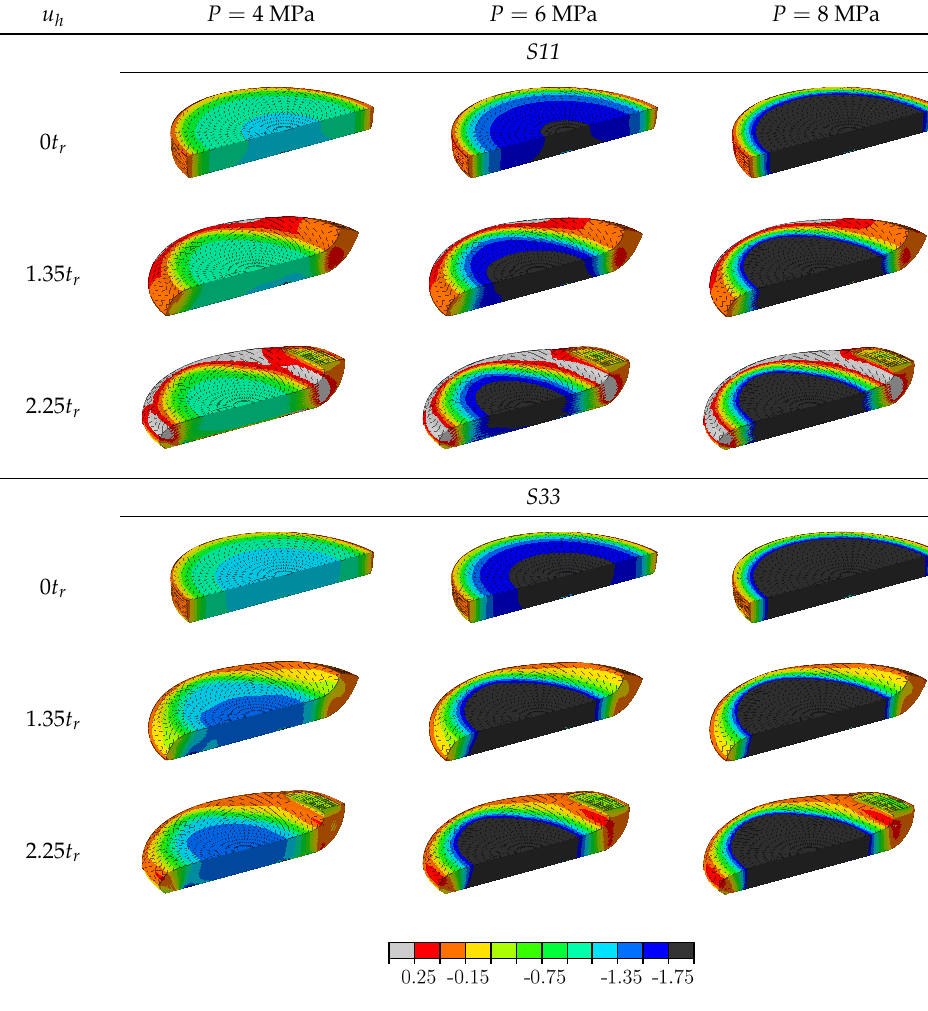
Figure 24. Influence of vertical pressure P on the normal axial S11 and vertical S33